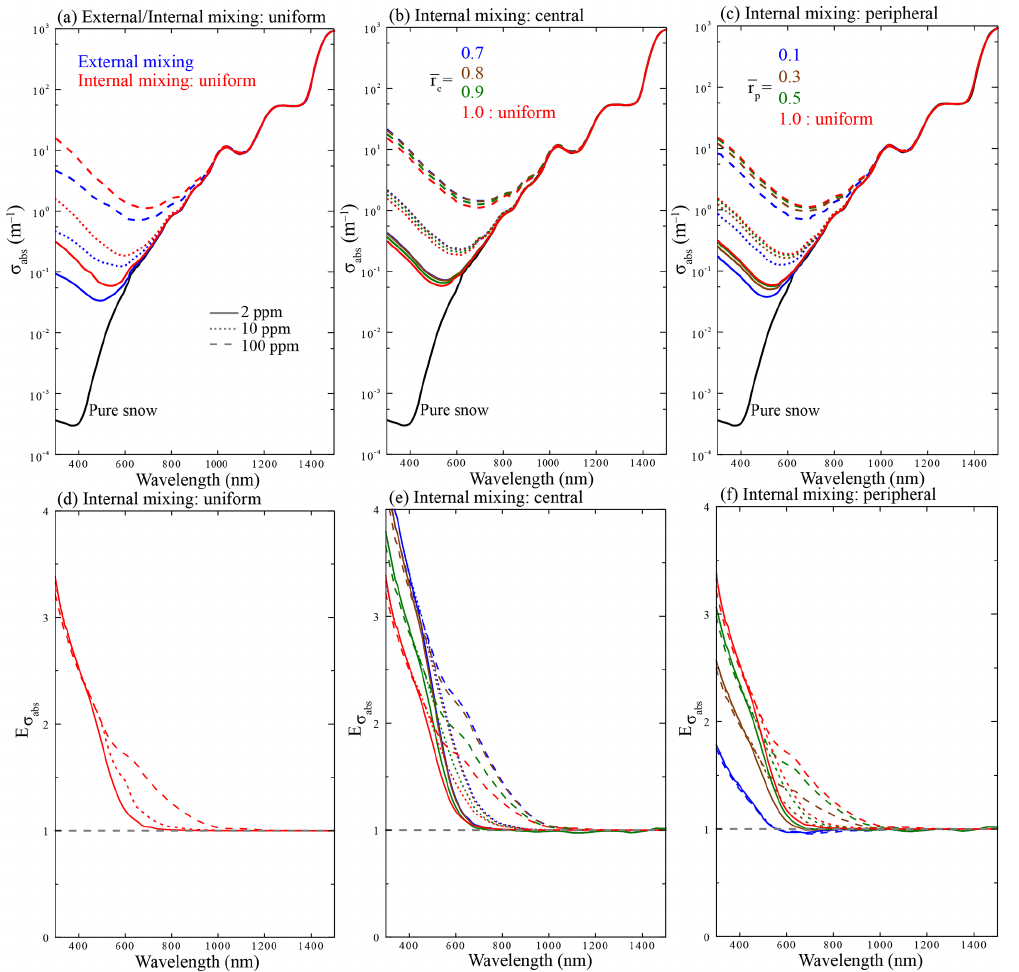
Figure 4. Snow absorption coefficients ( σ abs ) for dust–snow (a) external and internal mixing (uniform), (b) internal mixing (central), and (c) internal mixing (peripheral), as a function of wavelength with different dust concentrations and r c and r p . The corresponding enhancement (E σ ) caused by (d) internal mixing (uniform), (e) internal mixing (central), and (f) internal mixing (peripheral) relative to external mixing, abs is shown as a function of wavelength. The snow grain radius was assumed to be